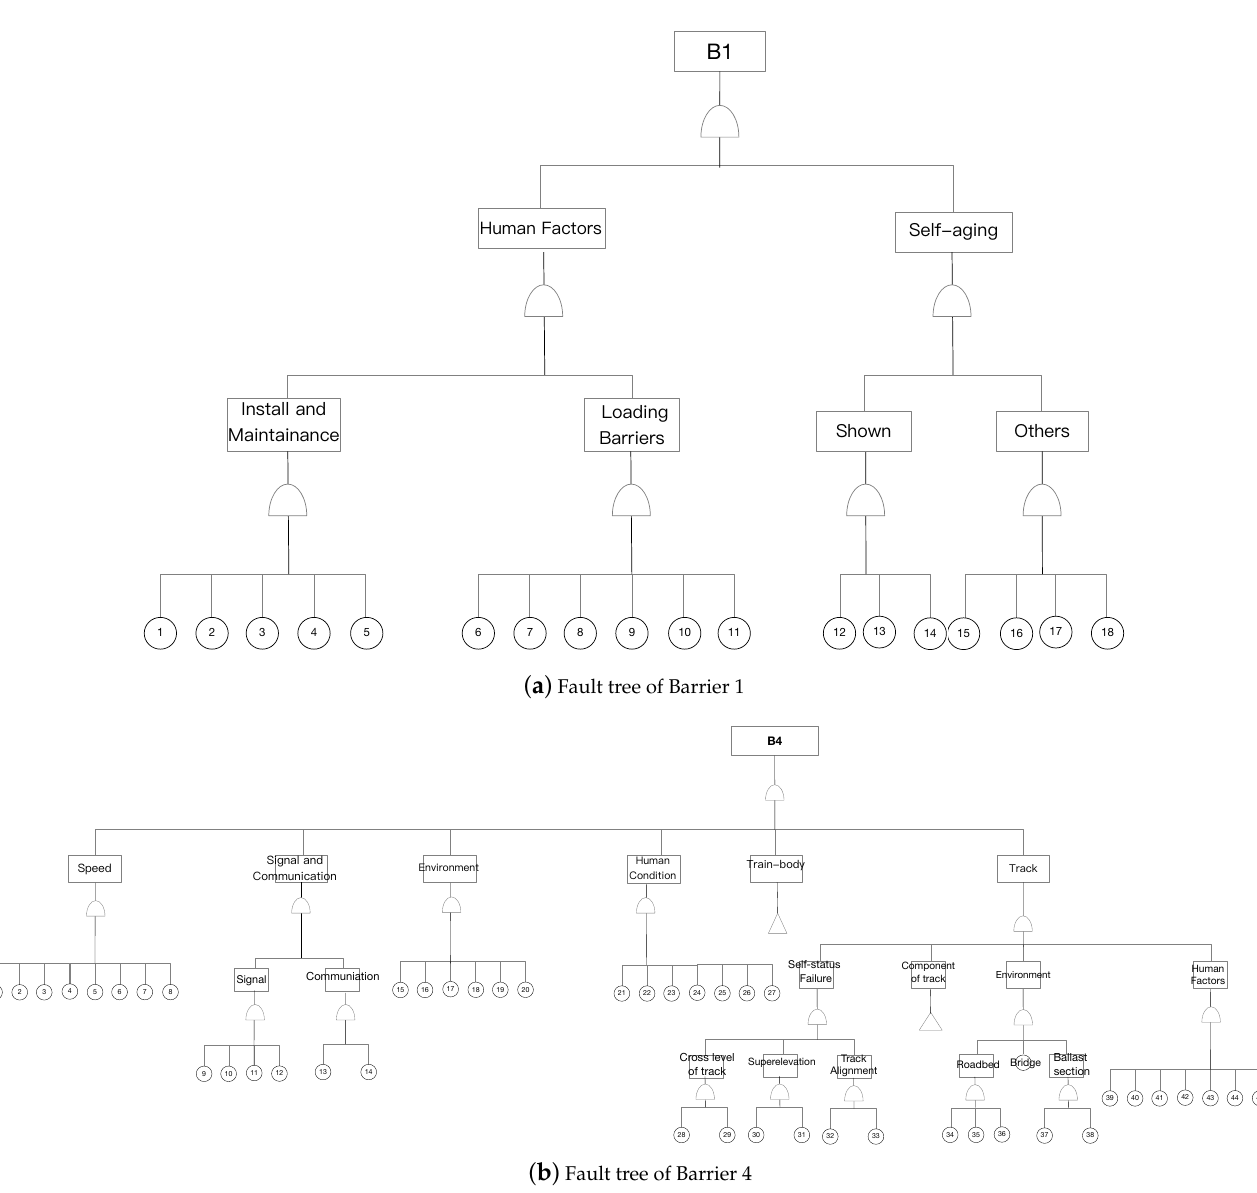
Figure 7. Proposed fault trees from text data (please refer to the Appendix (Tables A1 and A2) for the meanings of the symbols).